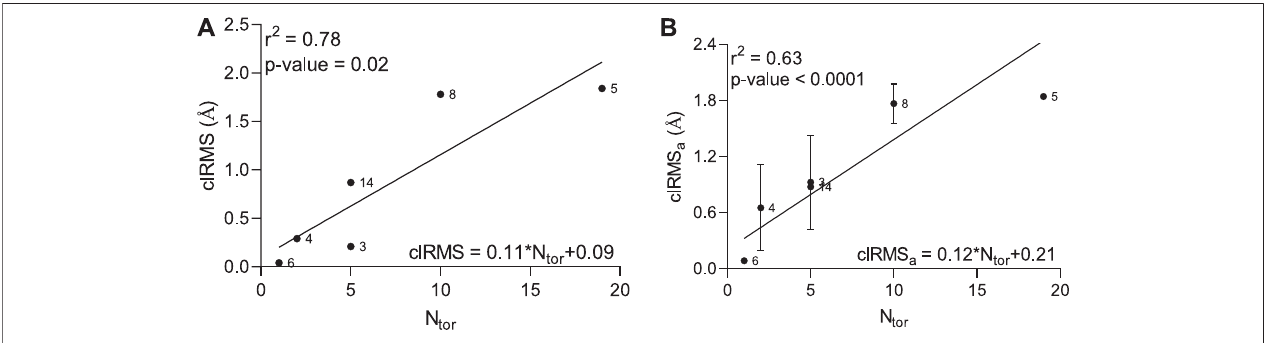
FIGURE 1 | Relationship between clRMS (A) as a root-mean-square difference between top two conformations in the lowest-energy cluster, clRMSa (B) as an averageoftheroot-mean-squaredifferencebetweenallconformationsandthelowestenergyconformationinthelowest-energyclusterandthenumberoftorsions( N tor ) in the ligand